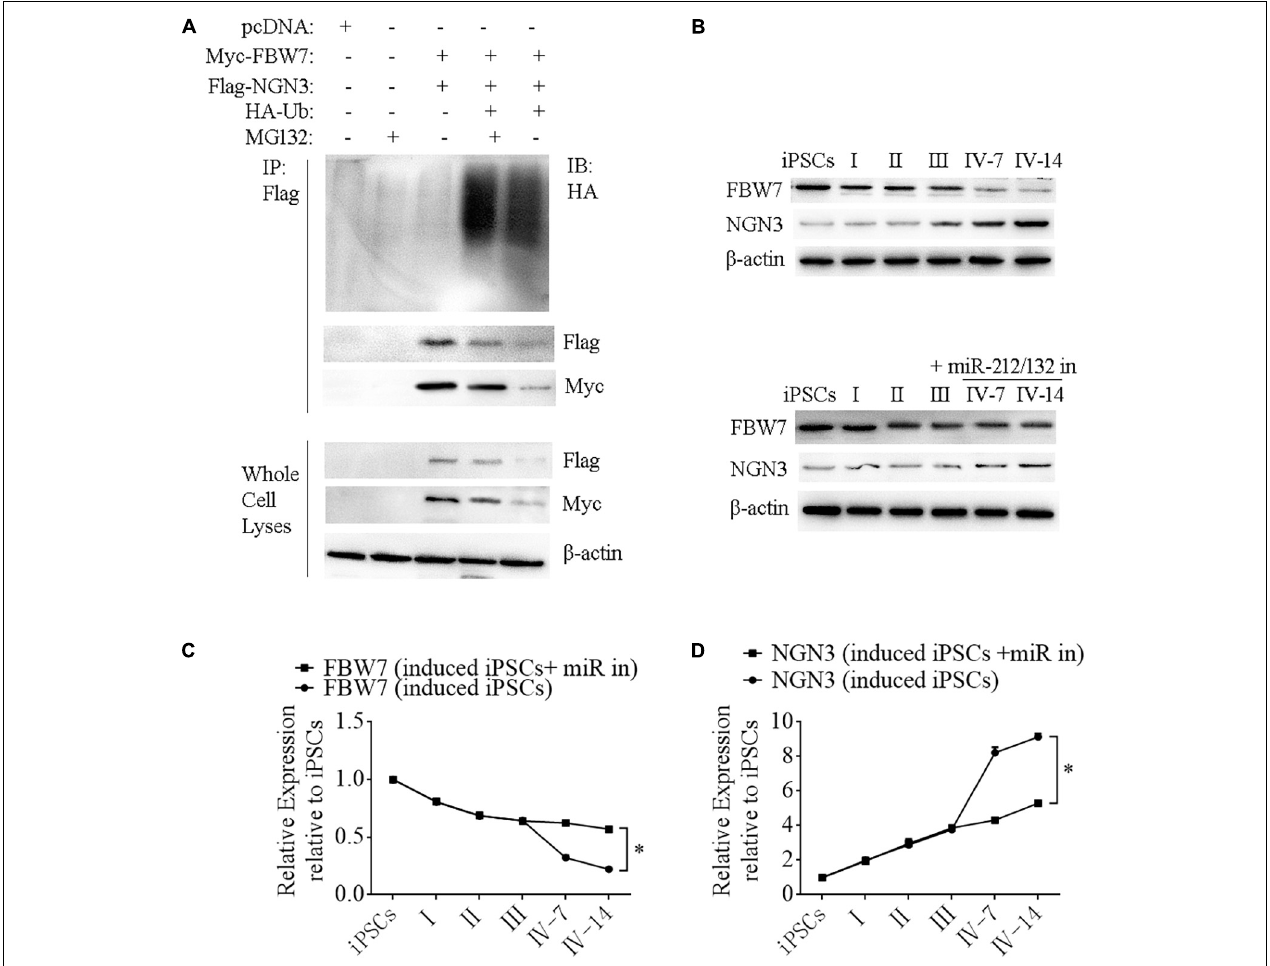
FIGURE 7 | FBW7 combines with NGN3 to promote NGN3 degradation through ubiquitylation. (A) Immunoprecipitation-western blotting showed that FBW7 interacted with NGN3 and promoted NGN3 degradation through ubiquitylation. Polyubiquitylated NGN3 was dramatically elevated in MG132-treated cells transfected with FBW7. (B–D) Western blot analysis of FBW7 and NGN3 protein levels during formation of i-Beta cells after silencing miR-212/132. Graph shows mean FBW7 and NGN3 protein levels normalized to β -actin as the percentage of protein levels in iPSCs. Values represent the mean ± SD of at least three